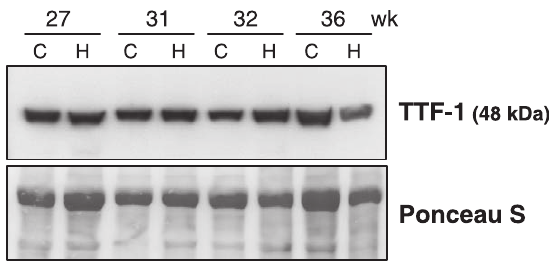
Figure 3. TTF1 Protein in Human Fetal Lungs Western blot was performed in lung samples of fetuses with CDH (lanes labeled H) and in fetuses with nonpulmonary diseases used as controls (lanes labeled C) at four fetal ages (Ponceau S stain was used as loading control). No differences were observed between CDH fetuses and age- matched control fetuses.